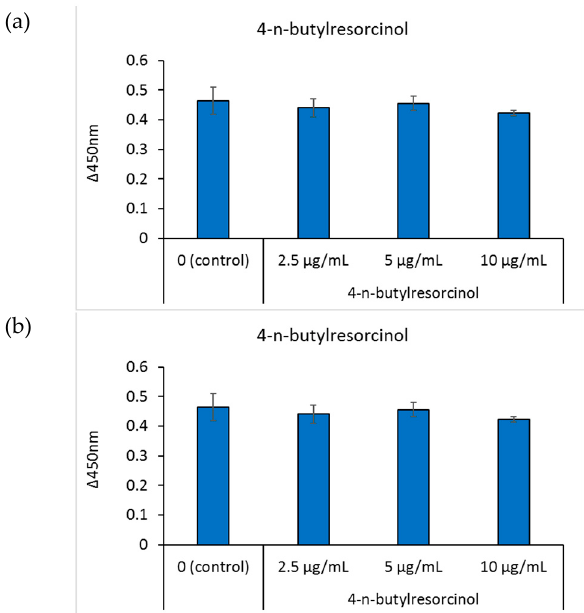
Figure 4. The effects of the tested compounds on the viability of B16 cells. Cell viability was determined by calculating the absorbance change rate in 2 h at 450 nm. ( a ): 4-n-butylresorcinol; ( b ): scutellarein. Data are presented as the mean ± SD of experiments performed in triplicate.